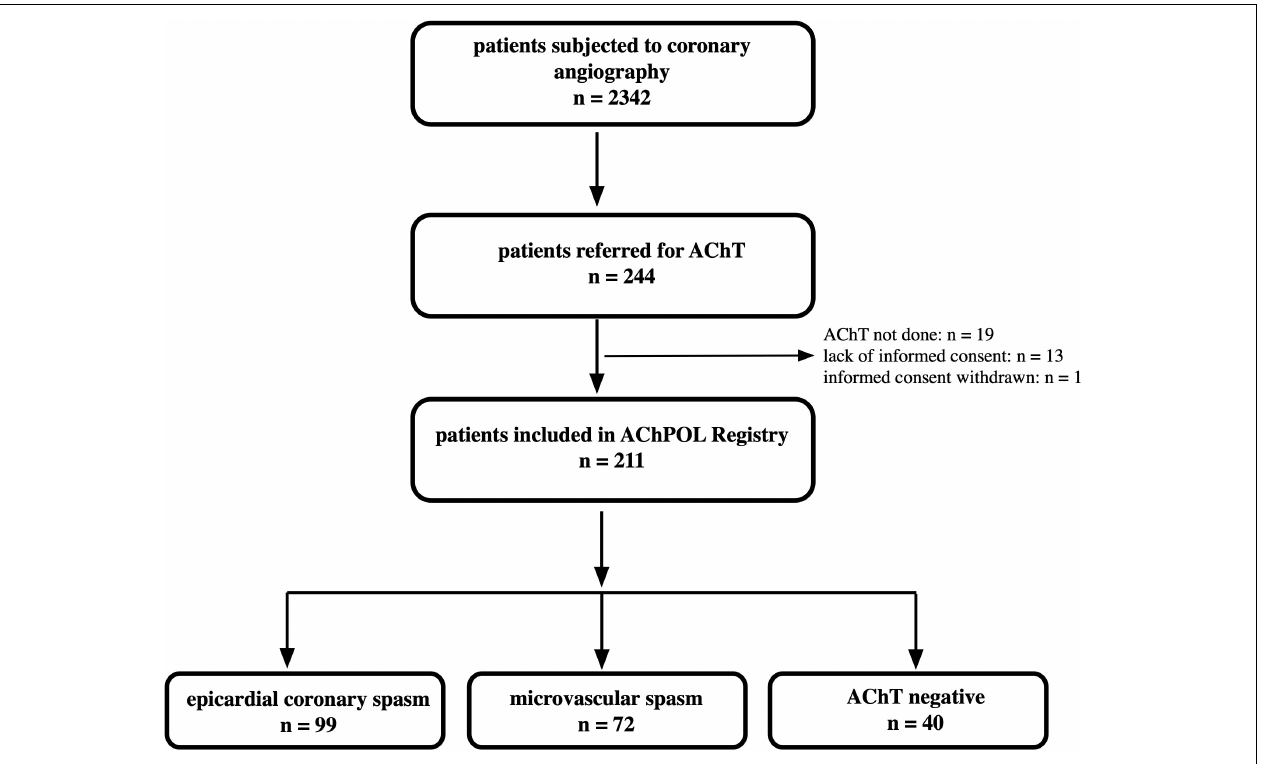
FIGURE 1 | The study flowchart. AChT, acetylcholine